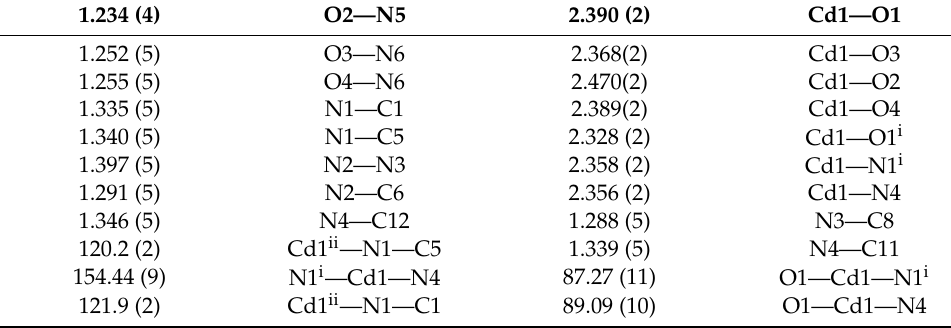
Table 2. Chosen bond lengths [Å] & angles [ ◦ ] for